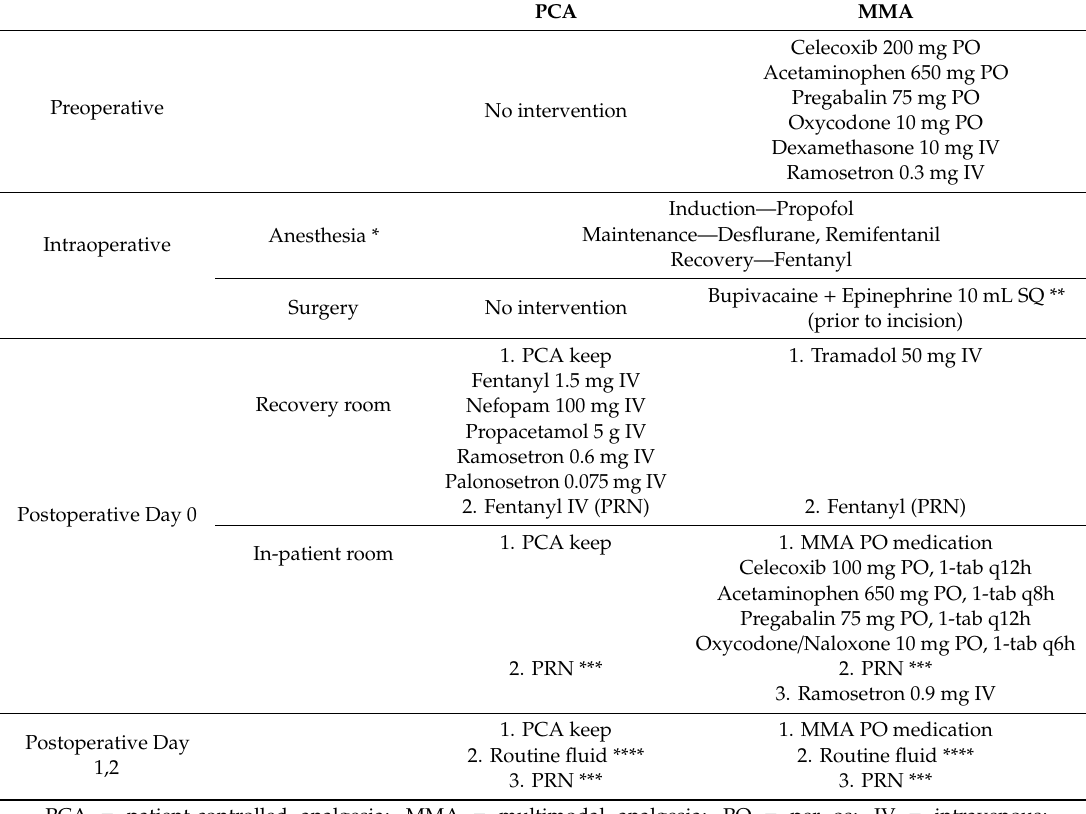
Table 1. Patient controlled analgesia (PCA) vs. Multimodal analgesia (MMA)